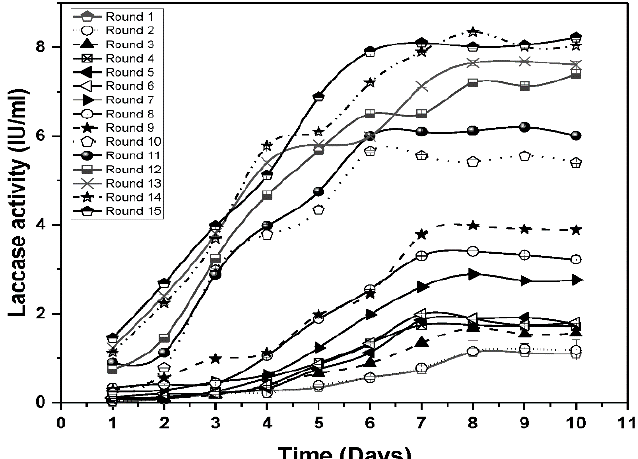
Figure 4. Maximal laccase activity in adapted strains of Geobacillus sp. strain WSUCF1 (eWSUCF1) during laboratory adaptive evolution with 0.5% ( w / v ) unprocessed corn stover (CS) and 0.025% ( w / v ) kraft lignin, at 60 °C, pH 7.0, and agitation speed of 150 rpm, after 10 days of incubation. Here, IU = International Units. Note: All the experiments were performed in triplicates, with data averaged and presented as the mean ± standard deviation (SD).